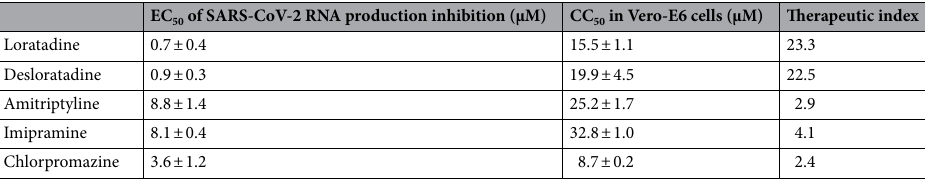
Table 1. EC 50 s, CC 50 s and therapeutic indexes of the 5 most potent CADs tested.